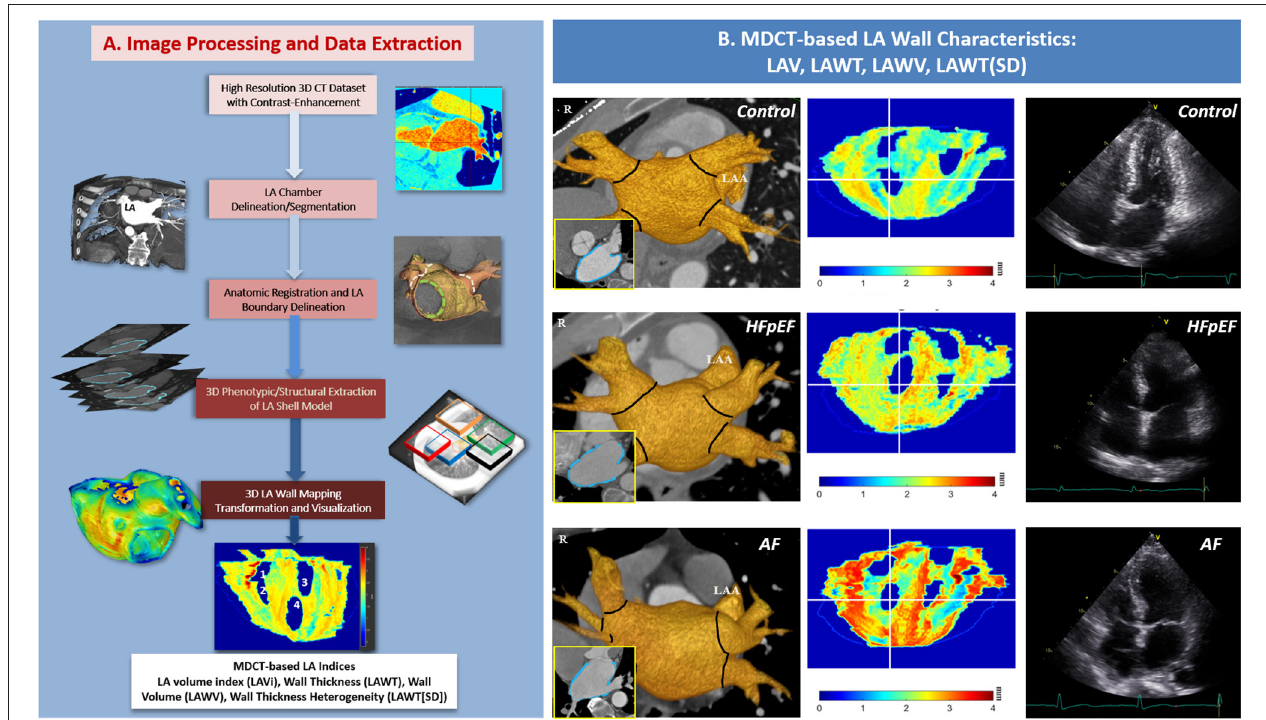
FIGURE 1 | Five major steps in the LA mapping workflow for LA wall indices in the current study: (1) LA delineation, (2) inner boundary segmentation, (3) outer boundary segmentation, (4) wall mass calculation, (5) three-dimensional (3D) projection map, and display of the LAWT (SD). The LAWT in each dataset was expressed by different colors as a visual projection map together with four PVs orifices. Nos. 1, 2, 3, and 4 represent the right superior, right inferior, left superior, and left inferior PVs, respectively (A) . Cardiac CT images from 3 representative individuals from the Control, HFpEF, and AF groups (B) . LA, left atrial; LAWT, left atrial wall thickness; LAWT (SD), left atrial wall thickness heterogeneity; PV, pulmonary vein; MDCT, multi-detector computed tomography; HFpEF, heart failure with preserved ejection fraction; AF, atrial